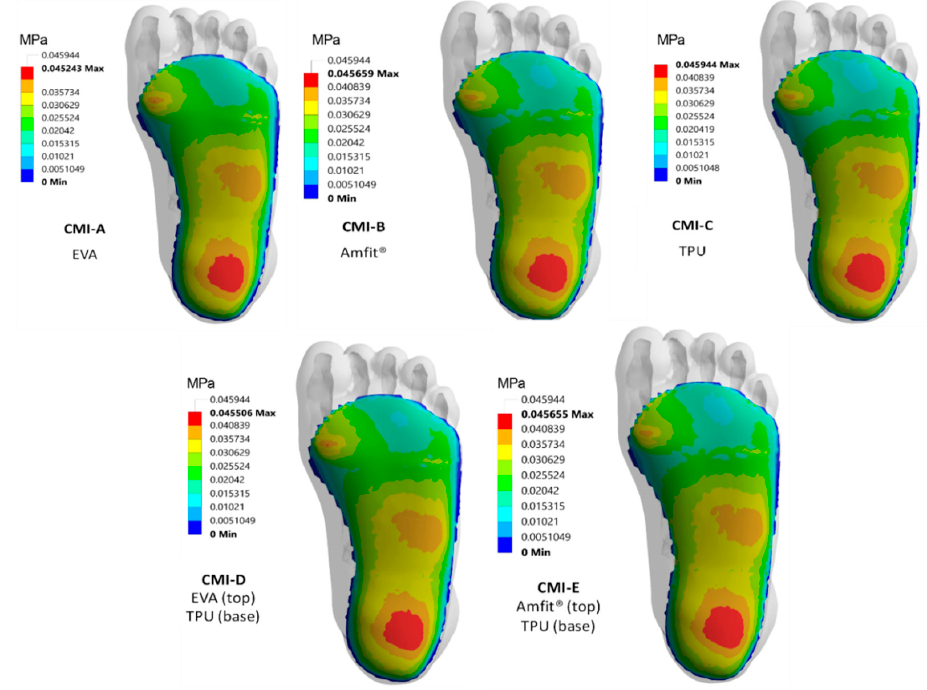
Figure 4. The contact pressure distribution with soft material to stiffer material and its combinations.